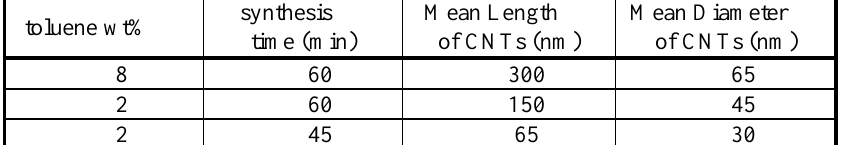
Table 1. Comparison of CNTs Specification based on toluene wt% and synthesis time